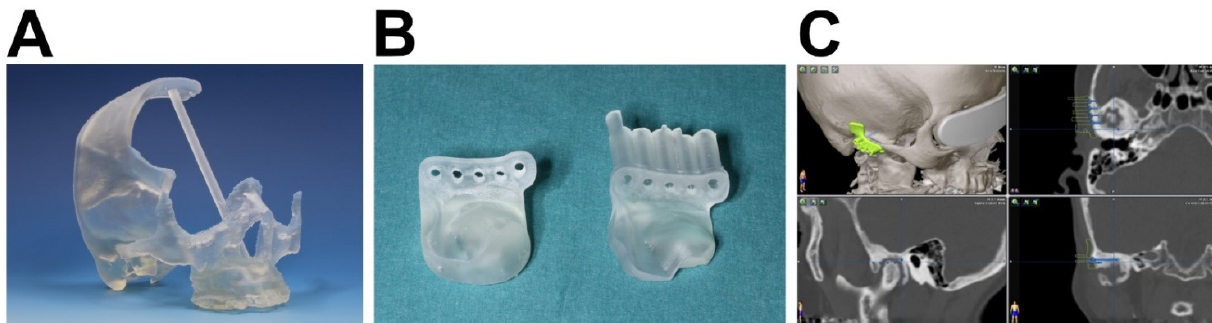
Figure 1. Preparation of model surgery ( A ) A 3D-printed (Clear resin, Form2 ® , Formlabs Inc., Somerville, MA, USA) model of a patient’s skull base with right glenoid fossa and parts of the calvaria for fixation of a navigation reference array (see also Figure 2C). ( B ) The simple (left) and newly designed advanced (right) drilling guides for vector and length control (Clear resin, Form2 ® , Formlabs Inc., Somerville, MA, USA). ( C ) “Preoperative” virtual surgical plan with stereolitographic model of the advanced drilling guide (green-yellow) and trajectory planning of screw positions and vectors (blue lines with dots on each end) using Brainlab ® iPlan CMF 3.05.